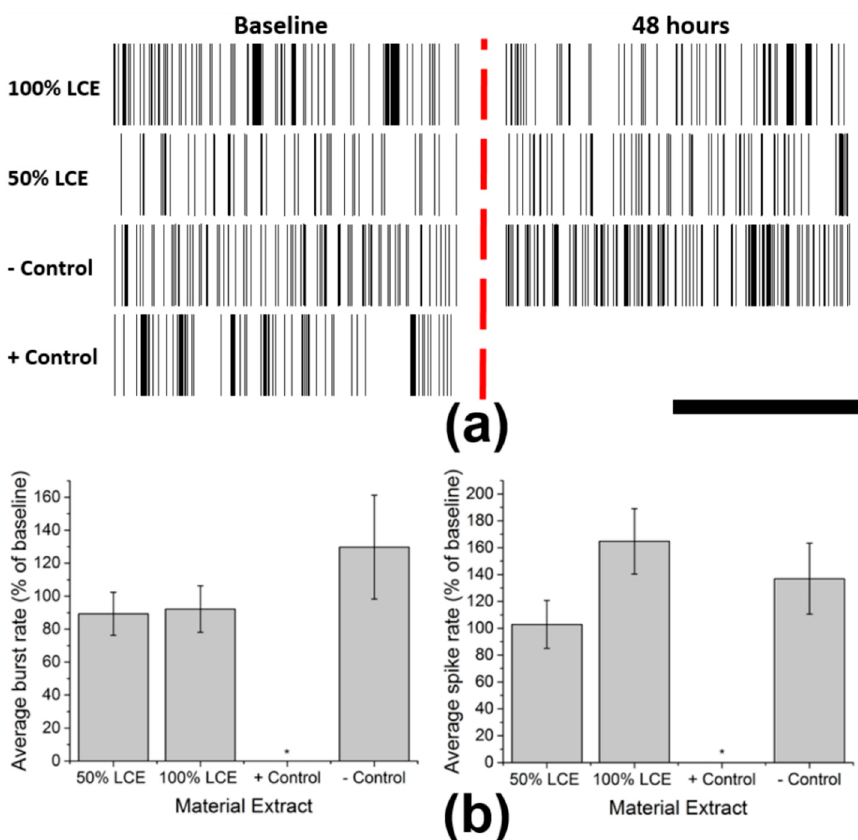
Figure 3. Functional neurotoxicity assays using primary cortical neurons: ( a ) Representative raster plots of spontaneous activity from single electrodes before ( left ) and after ( right ) each treatment. Scale bar represents 3 s. ( b ) Average Burst rate ( left ) and spike rate ( right ) of cortical neurons after 48 h exposure to LCE extract at 50% and 100% concentrations, positive control, and negative control.